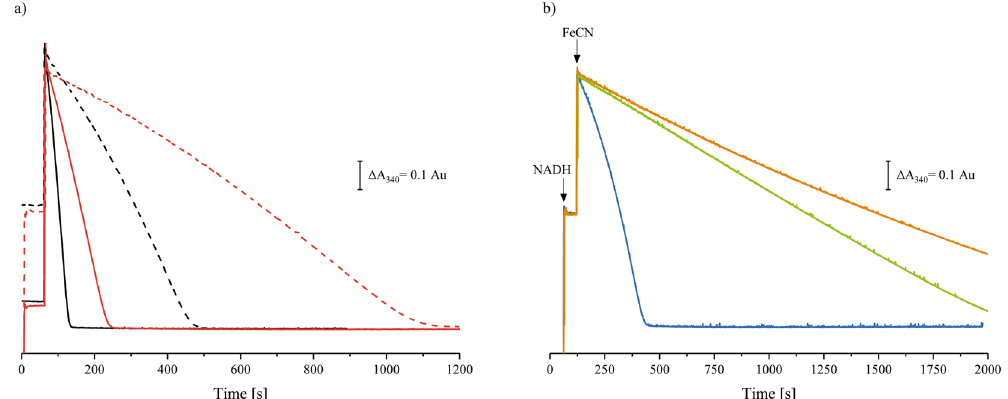
Figure 2. NADH:ferricyanide oxidoreductase activity of isolated E. coli complex I. ( a ) Shows the activity of 10 nm (black) and 2 nm (red) isolated complex I. The assays contained 150 µ m NADH and 1 mm ferricyanide in 50 mm MES/NaOH, 50 mm NaCl, pH 6.0. The reaction was either started by an addition of NADH (solid line) or ferricyanide (dashed line). ( b ) Shows the activity of 5 nm (blue), 0.9 nm (green) and 0.5 nm (orange) complex I